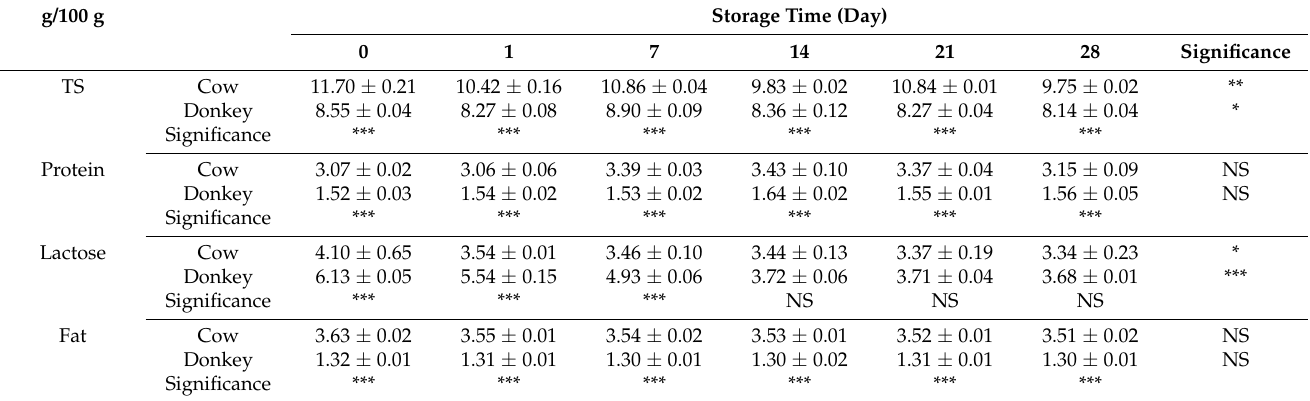
Table 1. Biochemical composition evolution of cow and donkey kefirs during storage time at 4 ◦ C.